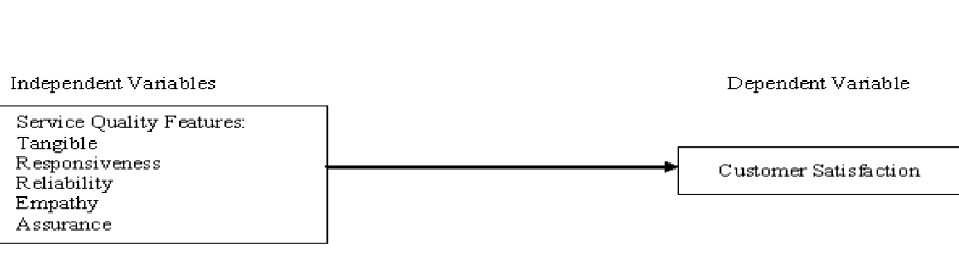
Figure 1. Relationship between service quality features and customer